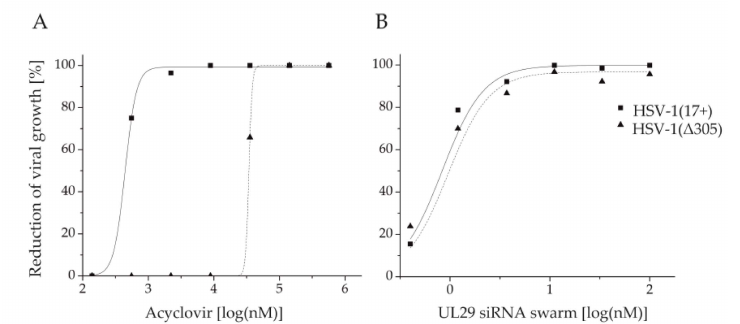
Figure 2. The thymidine kinase ( UL23 ) defective HSV-1 strain ( ∆ 305), and reduction of its growth in response to elevating concentrations of ( A ) acyclovir (ACV) or ( B ) UL29 siRNA swarm. HSV-1 ( ∆ 305) is shown as a dotted line and triangles. The corresponding curve of the reference strain HSV-1 (17 + ) is shown with a solid line and squares. Both the UL29 siRNA swarm and ACV were studied for prophylactic e ffi cacy, with treatment given four hours before infection. The assays were conducted on 96-well plates with a virus dose of 100 pfu per well. The dose is shown as log(nM) for both antivirals and the response is shown as inhibition percentage (%) versus untreated cells for ACV and versus water-treated for the UL29 siRNA swarm. The ACV plaque reduction assay was conducted in duplicates, and the antiviral siRNA swarm assay with five or more biological replicates for each concentration.